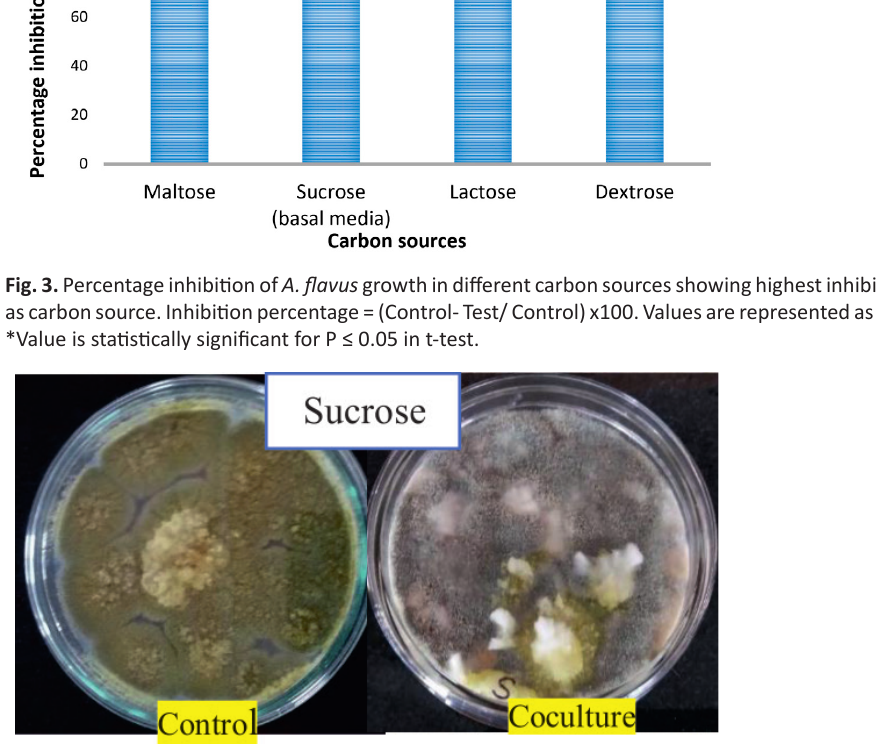
Fig. 4. Antagonistic effect of A. giganteus on pathogenic A. flavus during coculture in media with sucrose as carbon source